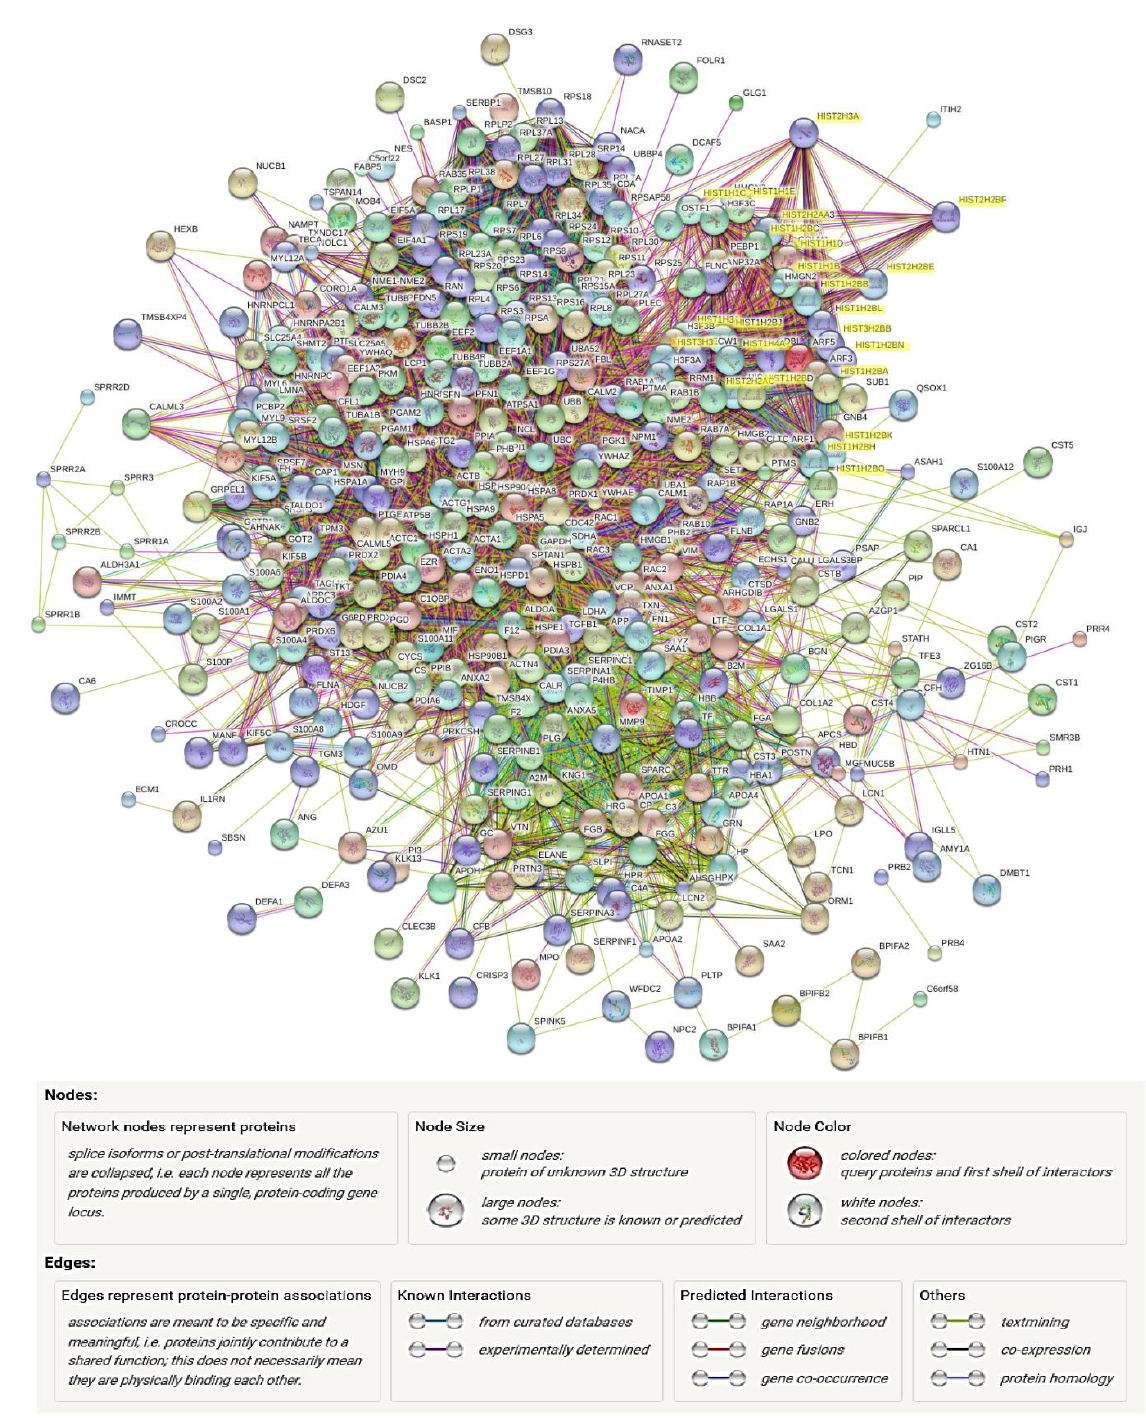
Figure 3. Visualization of protein interaction network of experimental in vitro tooth surface salivary pellicle proteins (unpublished data). The complex experimental protein data could be submitted to various software platforms to visualize the dynamic interactions between the identified proteins. Through network demonstration, some proteins are found possessing dynamic connections with many other proteins, such as histones (HIST, highlighted yellow). However, the complication of global networks limits the direct information visualizations, thus further simplifications may be needed to gain better resolutions. Image generated by STRING platform (http://stringdb.org, accessed on 28 February 2021) through searching genomic associations between genes.